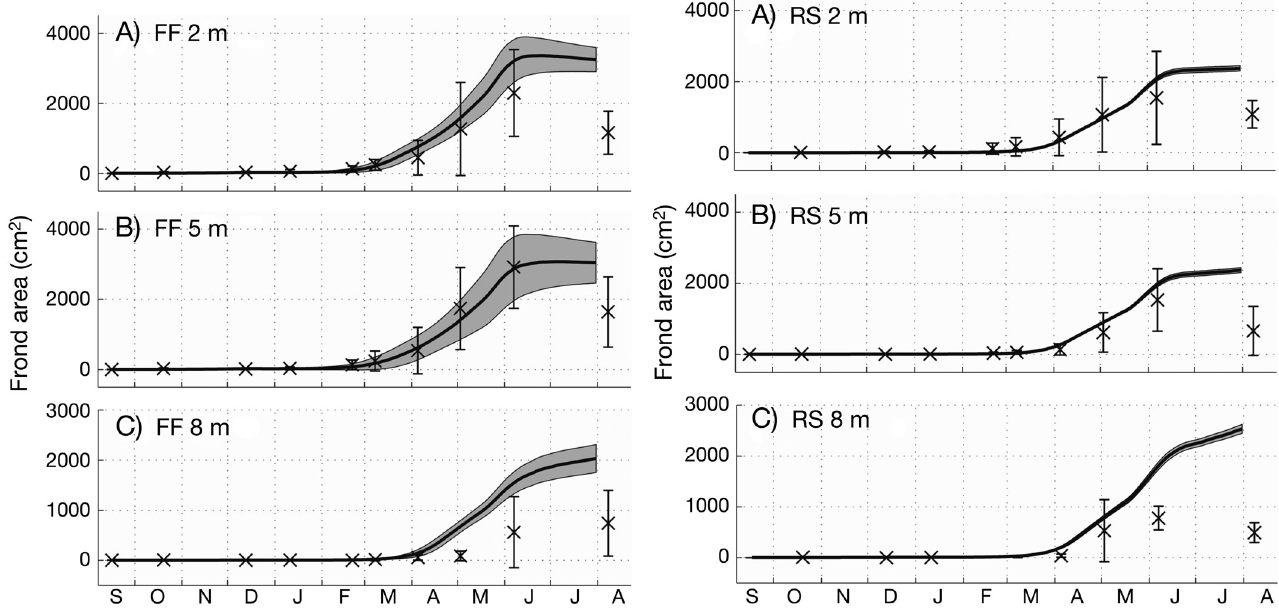
Fig. 8. Saccharina latissima . Average simulated (Simulation B Aug,N , continuous lines) and measured (crosses) frond areas (cm 2 ) for the August deployment at the fish farm (FF) station (Fig. 1B) at (A) 2 m, (B) 5 m and (C) 8 m depth. The shaded regions and error bars indicate standard deviations of simu- lated and observed values, respectively